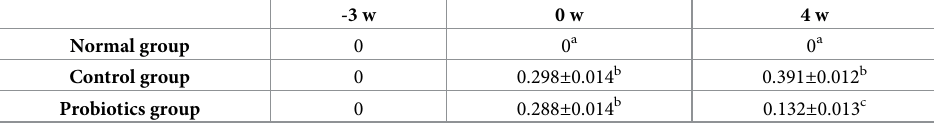
Data represent Plasma DX-4000-FITC ( μ g/mL). There is no detection of DX-4000-FITC in the blood without impaired intestinal